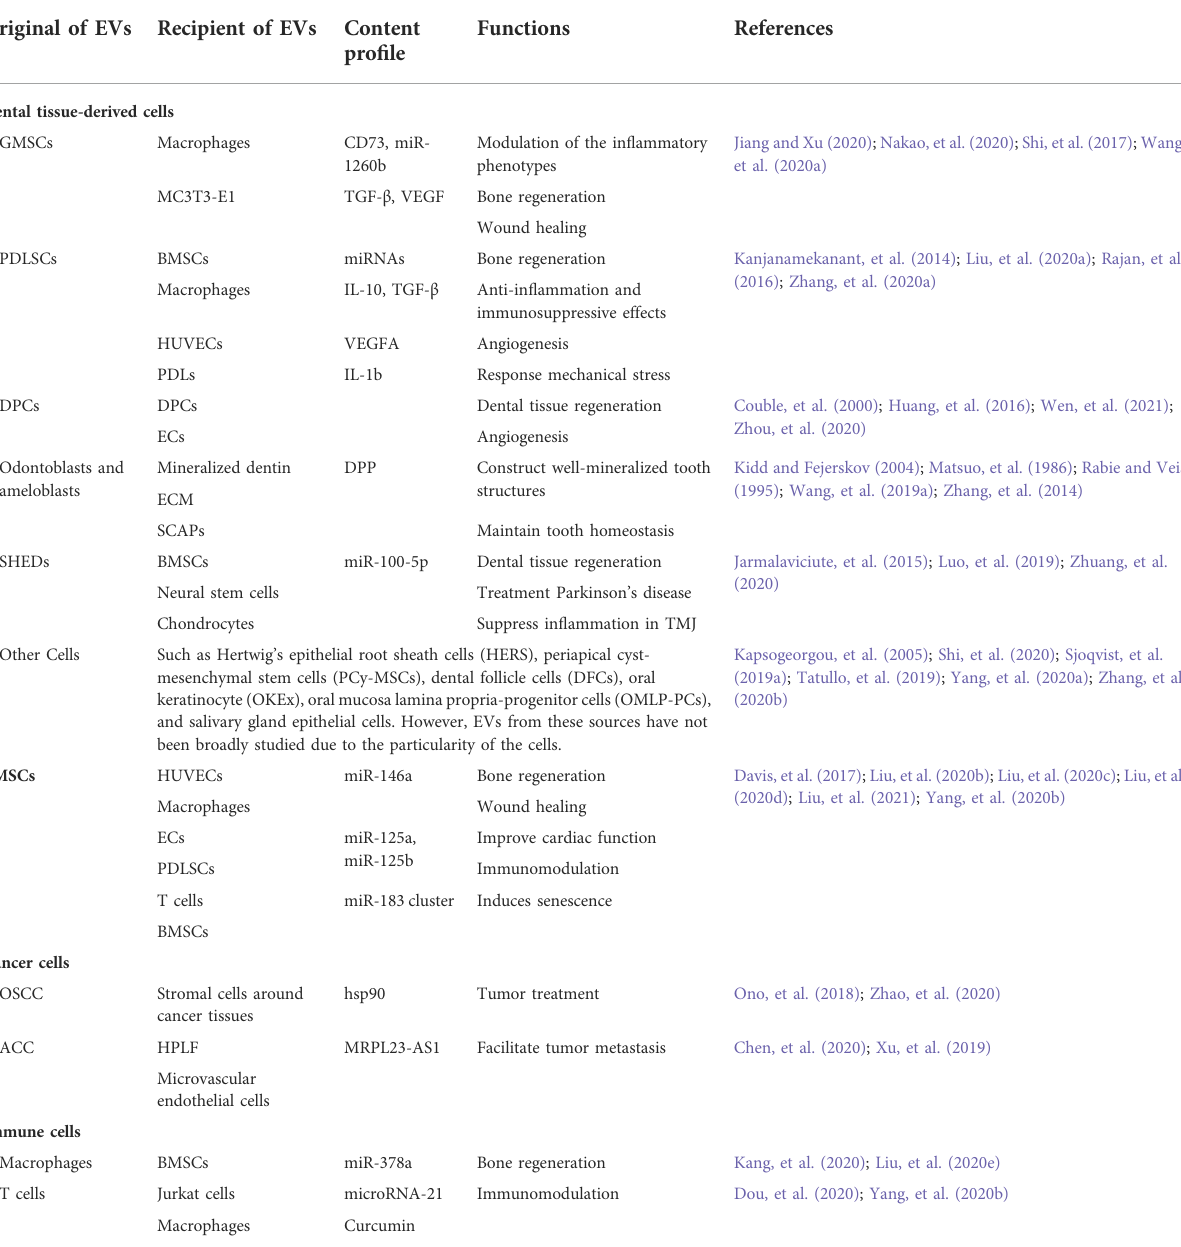
TABLE 1 The cell sources and features of extracellular vesicles